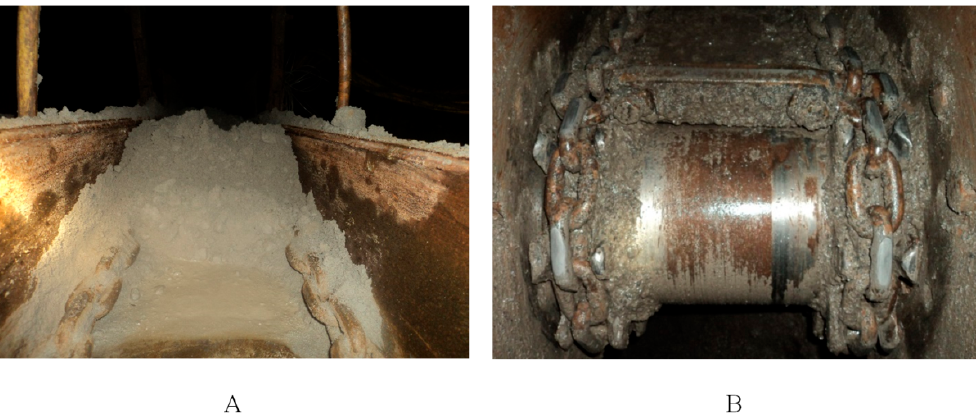
Figure 1. Examples of the presence of dry mineral abrasive ( A ) and mixture of water with abrasive ( B ) on transmission elements in corridor conveyors.